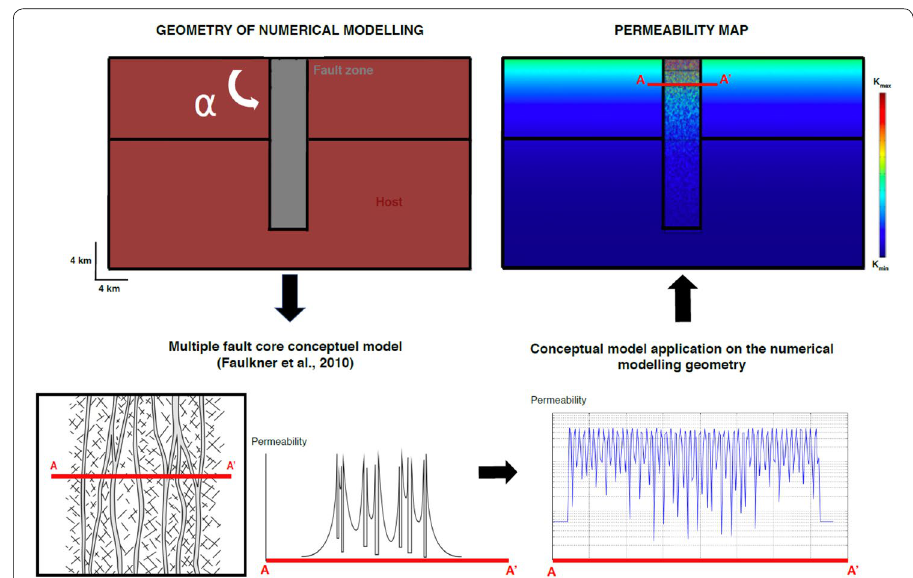
Fig. 5 Permeability imposed in the numerical models of the parametric study. The alpha angle corresponds to the dip of the fault zone (here α 90°). The permeability of the basement and fault will decrease with = depth according to Eq. 6 (Garibaldi et al. 2010). Within the fault zone, permeability will also vary laterally (Eq. 7) to match field